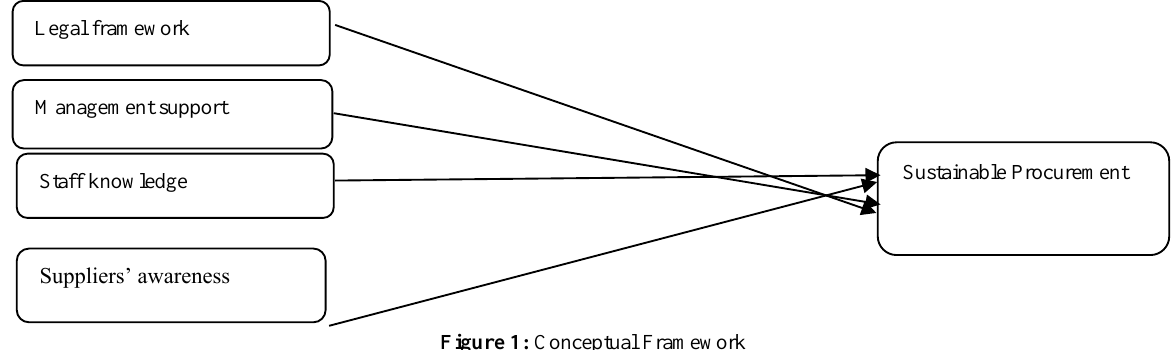
Figure 1: Conceptual